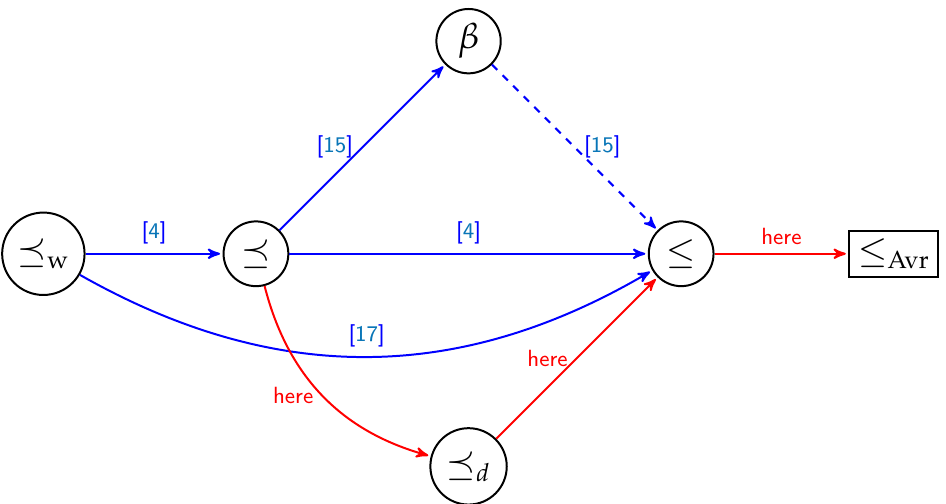
Figure 1. Order ( , , , ) and preorder relations ( (cid:22) w (cid:22) (cid:22) d ≤ connections in red are the results coming from this article. The dotted edge from β to order relation that is valid only for a sub-interval of [ 0,1 ]